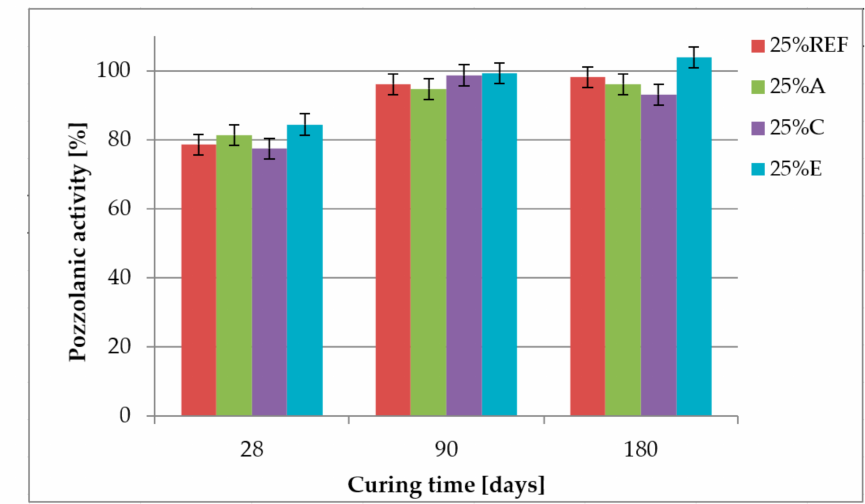
Figure 8. Activity index of fly